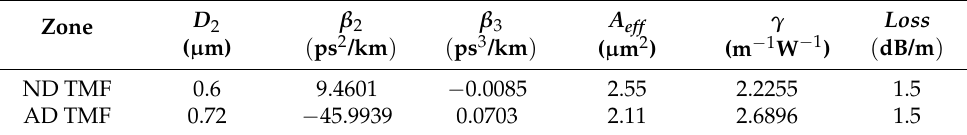
Table 1. Some of the main simulation parameters of ND TMF and AD TMF.